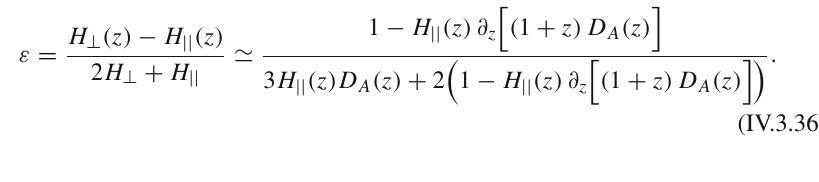
Fig. 60 Left: same as Fig. 59 but now with superimposed the prediction for the Lemaître–Tolman–Bondi model considered by García-Bellido and Haugbølle (2008a). Right: zoom in the high-redshift range